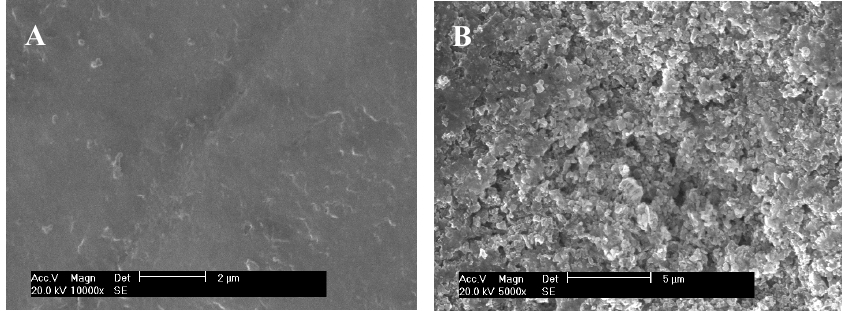
Figure 3. SEM micrographs of ( A ) NIP/Au; and( B ) MIP/Au after the template extraction.